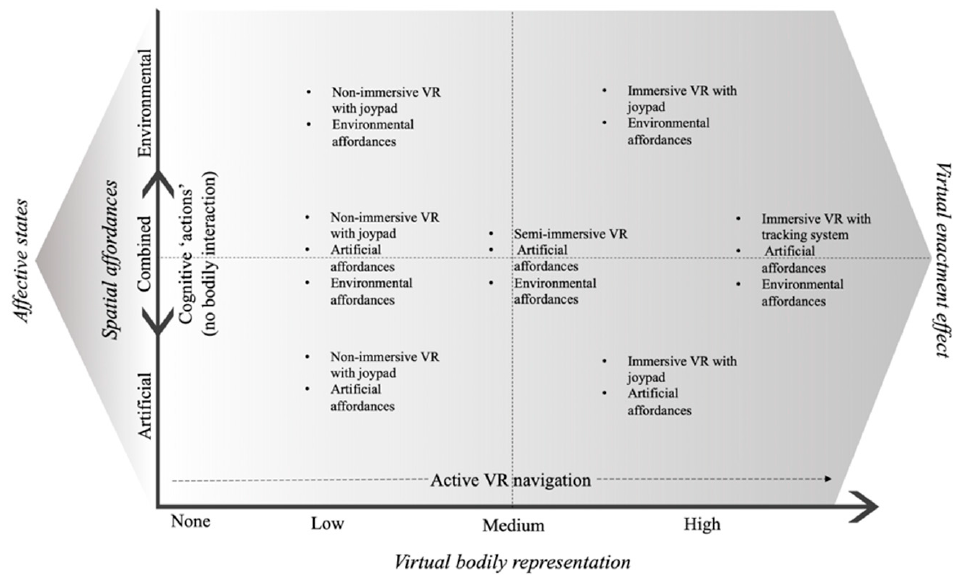
Figure 1. Summary of the embodied space approach and how virtual body representation, spatial affordances, and affective states could interact to foster virtual enactment effect. VR = virtual real- ity.